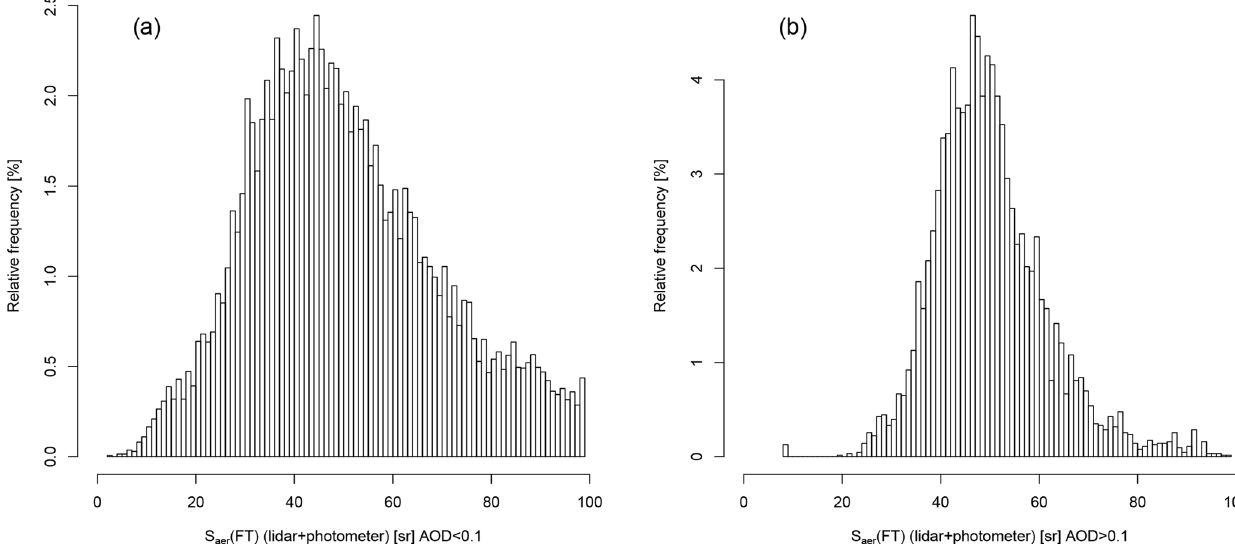
Figure 9. Histograms of the FT lidar ratios at 523nm obtained from two-layer inversion for (a) AOD IZO < 0 . 1 and (b) AOD IZO > 0 . 1.